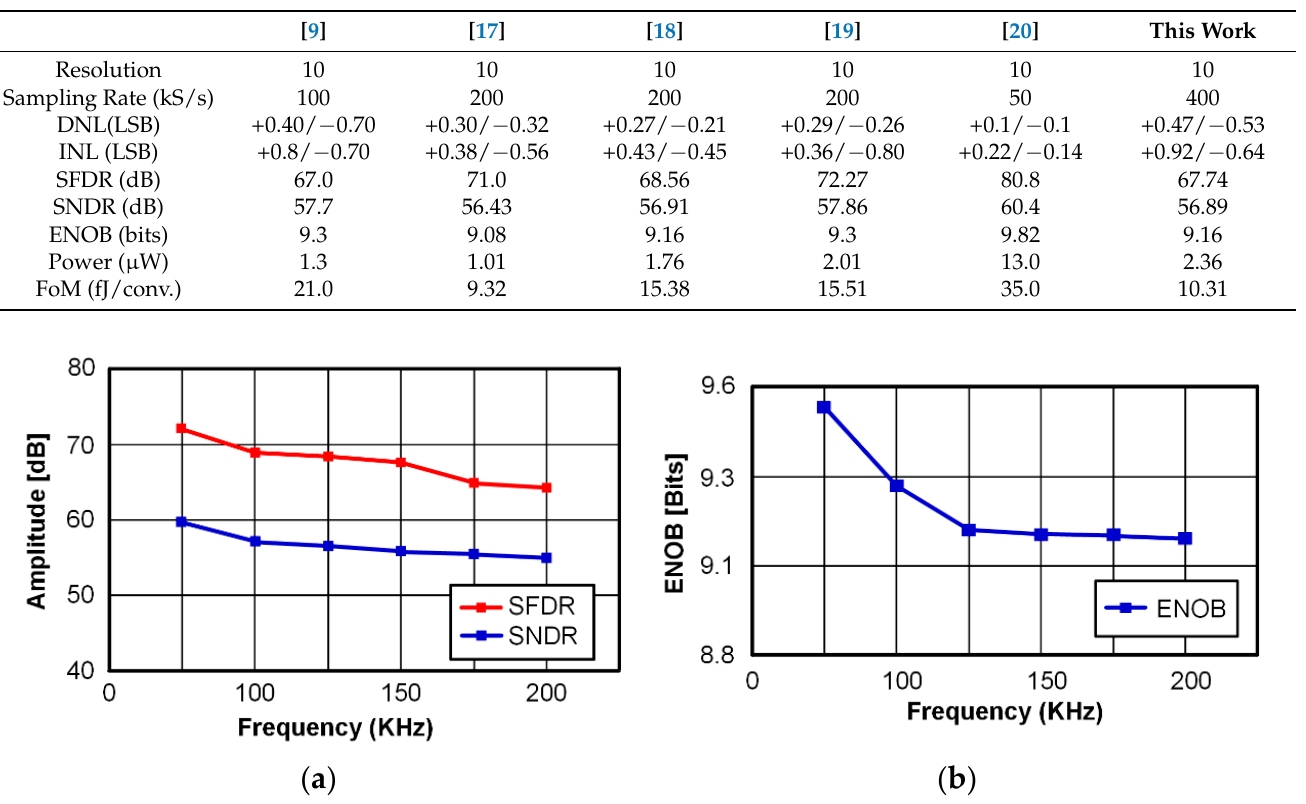
Figure 16. ( a ) SFDR and SNDR versus input frequency at 400-kS/s sampling rate; ( b ) ENOB trend of the proposed SAR ADC with various input frequencies at 400-kS/s sampling rate.